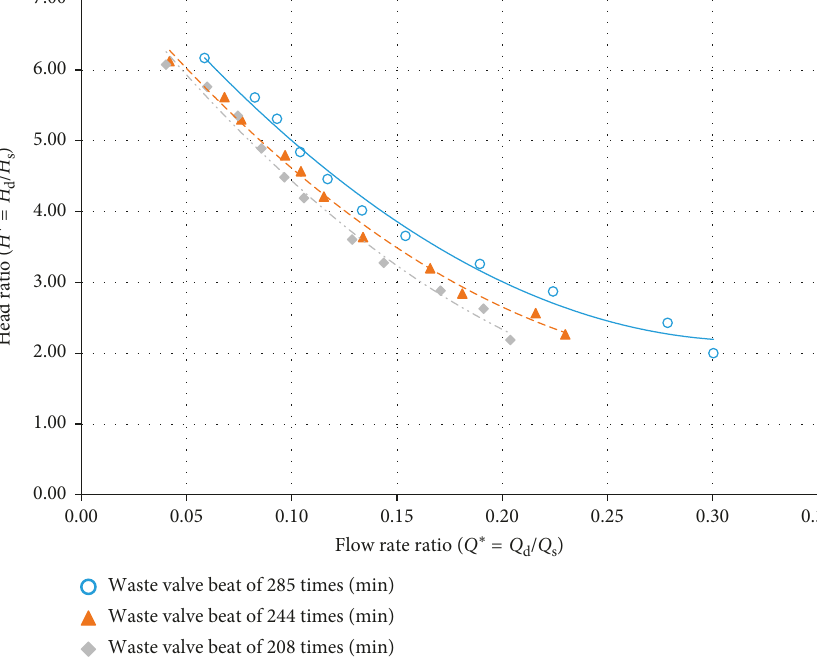
b (cid:31) 208, 244 and